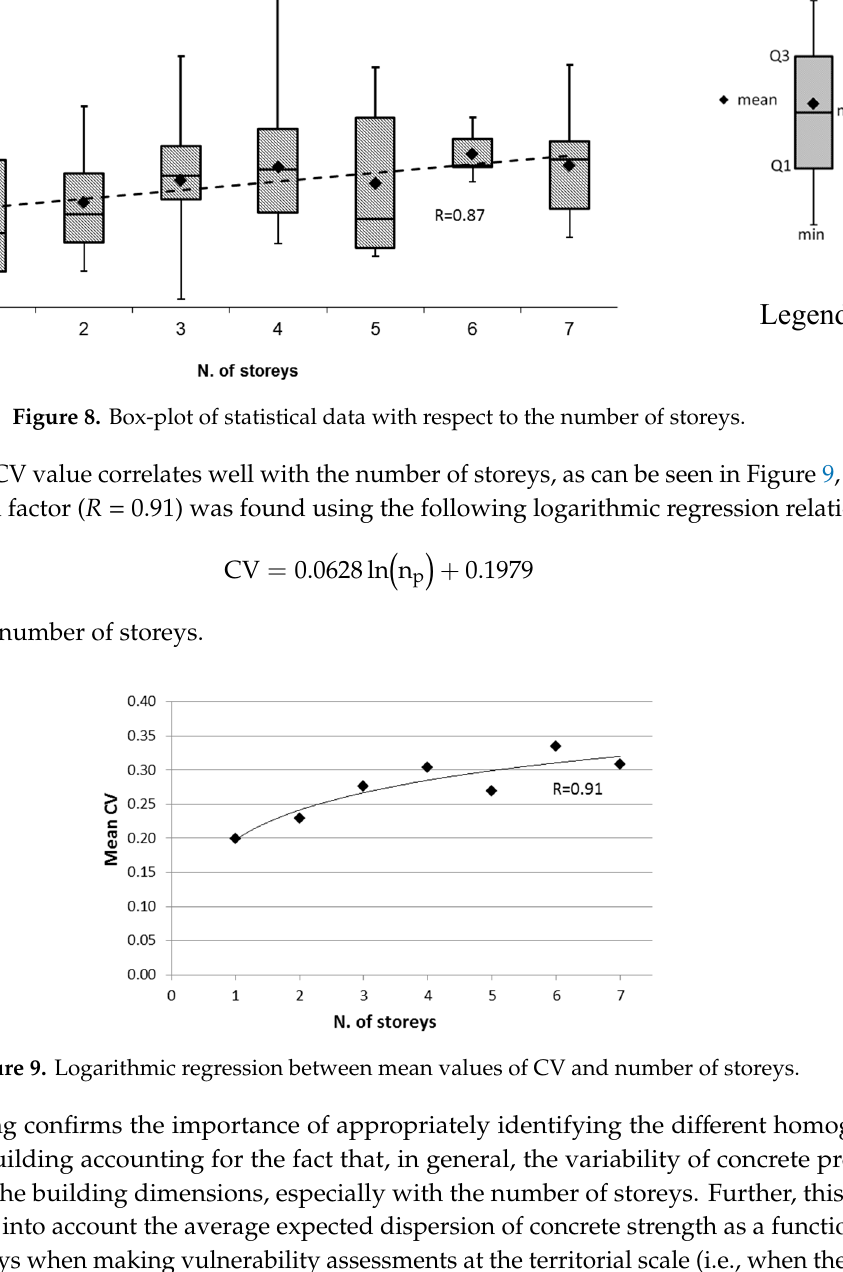
Figure 9. Logarithmic regression between mean values of CV and number of storeys.